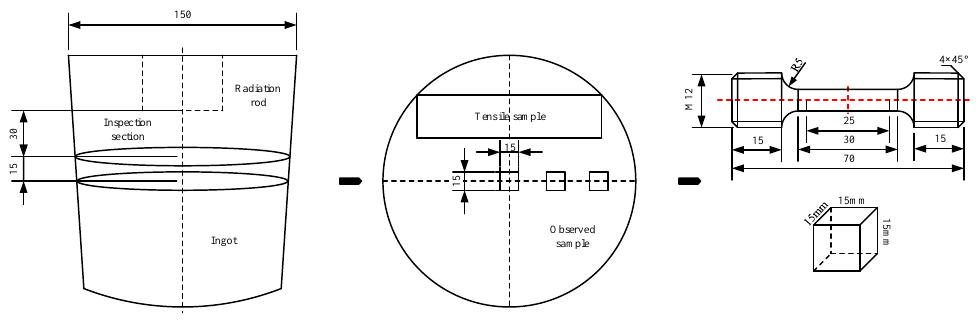
Figure 2. Schematic diagram of test-sample preparation.